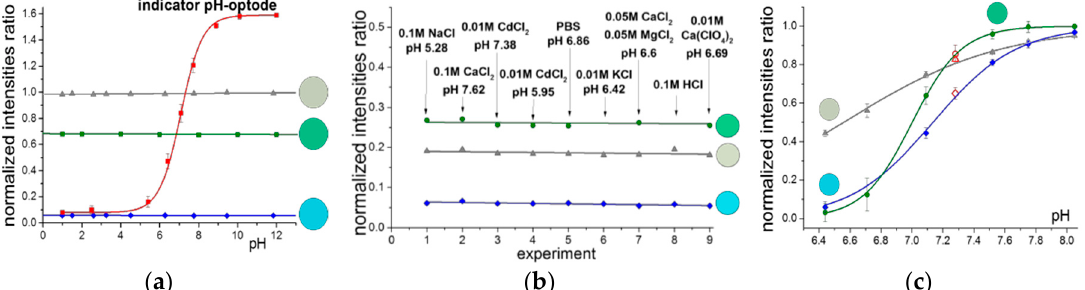
Figure 4. ( a ) pH response of the indicator optode (20 mM/kg ETH5350, 200 mM/kg NaVI, 22 mM/kg NaHFPB); the signal of the standard optodes with 20 mM/kg ETH5350 and 0 (blue) and 30 (green) mM/kg TBATBB and of the gray standard (triangles); ( b ) The signal of the same standards in various solutions; ( c ) Calibration curves for the same indicator optode in serum processed using conventional gray (triangles), blue (diamonds), and green (circles) standards. Red symbols: the signal measured in the sample and normalized with the respective